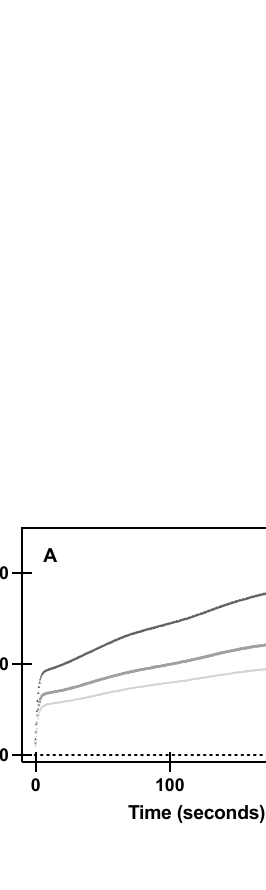
Table 1. Ligand binding parameter fits for a one-one model of receptor to ligand. K D and B max values reported as best fit ± S.E. from data shown in Figure 2. * Indicates p < 0.01, ** indicates p < 0.001, *** indicates p = 0.0001.